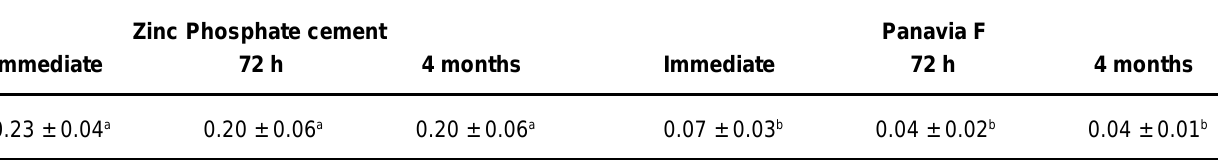
Values are expressed as mean ± standard deviation. Groups with same superscript letter were not significantly different (Tukey’s test; p>0.05).